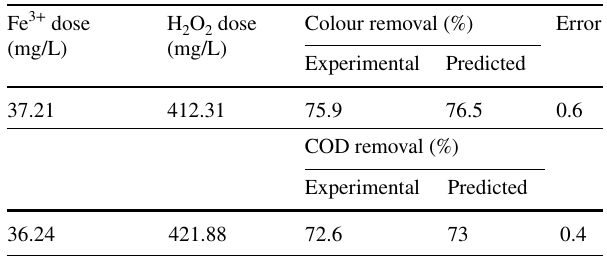
Table 5 Predicted and experimental values for the responses at